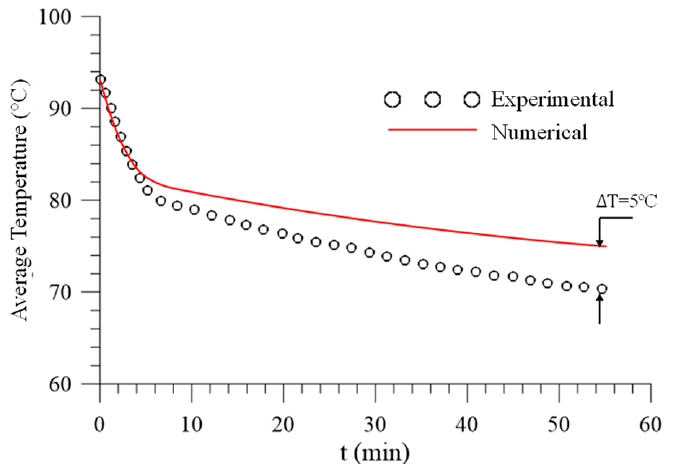
Figure 8. Comparison between numerical and experimental results of the average temperature of the PCM at z = 100 mm during the solidification process.